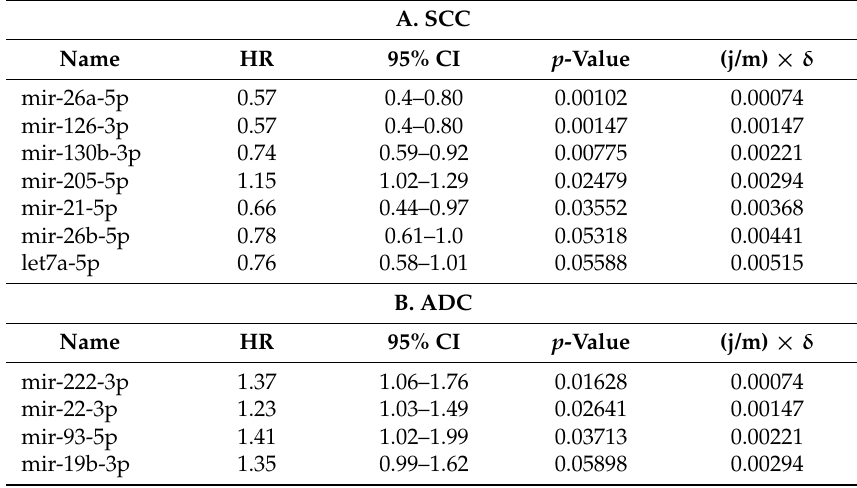
Table 3. miRNAs significantly associated with disease-free survival (DFS) at univariable